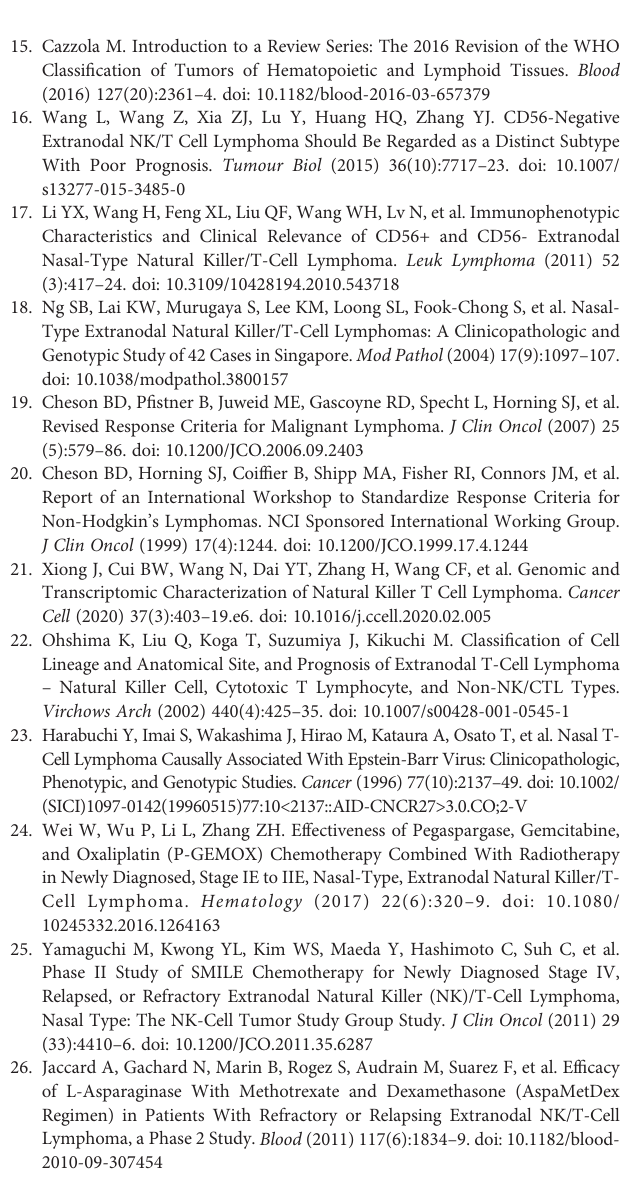
Supplementary Figure 2 | According to the algorithm conceived by Xiong et al. (reported in Cancer Cell. 2020), we reproduced the categorization of NKTCL according to NK-cell or T-cell origin. Supplementary Figure 3 | Using data reported by Xiong et al. (reported in Cancer Cell. 2020), CD56 was signi fi cantly elevated in patients with NK-cell origin. Supplementary Figure 4 | CIBERSORT analysis in groups with different cell origins, which were categorized using the algorithm conceived by Xiong et al. (reported in Cancer Cell.